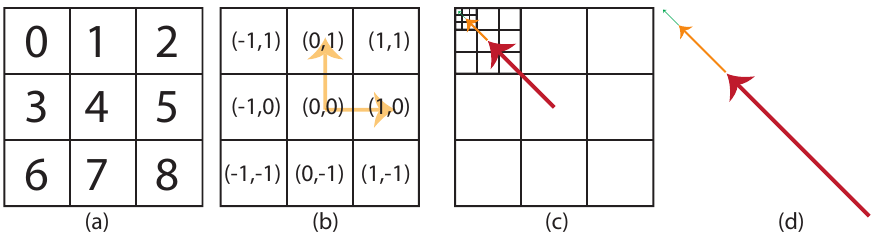
Figure 12. ( a ) Indices in the hierarchy-based indexing method used in SCENZ-grid and ( b ) the corresponding integer indices for each digit of (a) based on the defined coordinate system; ( c ) vectors corresponding to index I000; ( d ) magnified vectors from (c) for a better